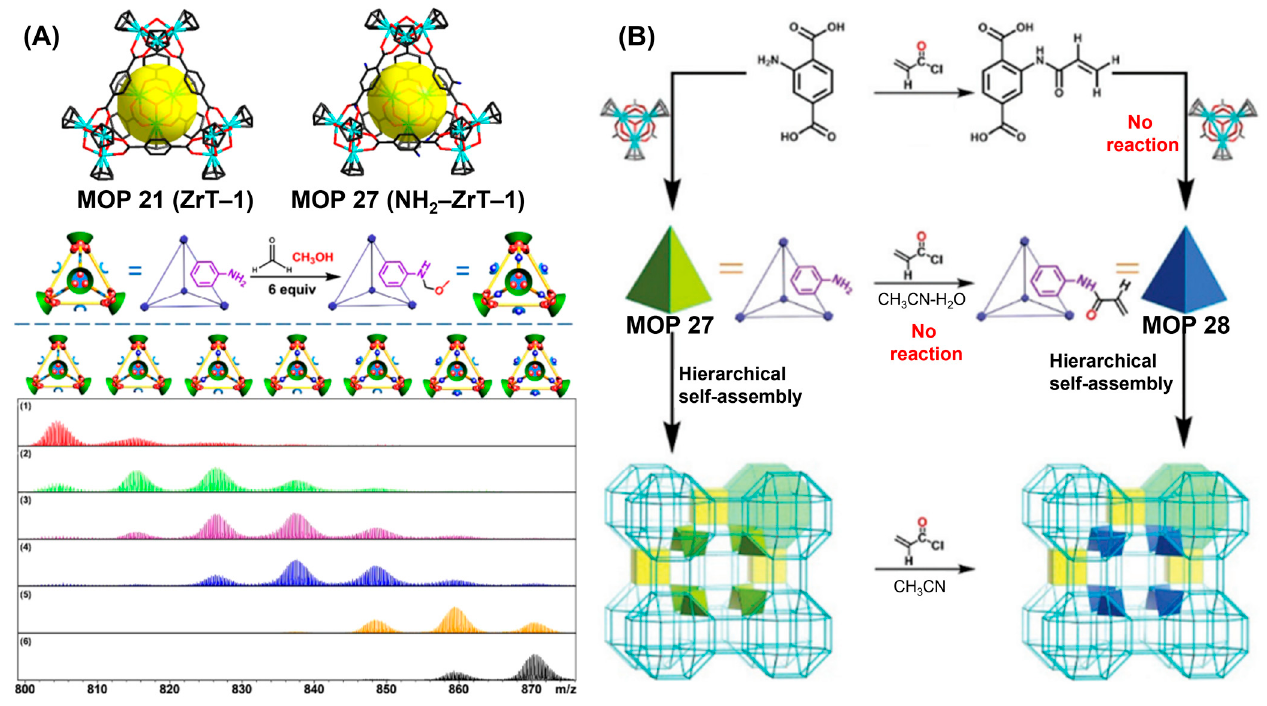
Figure 13. ( A ) Crystal structure of Zr-based MOP 21 and MOP 27. Schematic representation of post-assembly modification of MOP 27 upto six available sites in each cage. ESI-TOF MS spectra of MOP 27 in acetonitrile/water over a wide pH range. ( B ) Transformation of MOP 27 into MOP 28 via heterogeneous PAM in the supramolecular framework. Reprinted by permission from Refs. [136,137]. Copyright from 2018 from American Chemical Society and copyright 2021 from Royal Society of